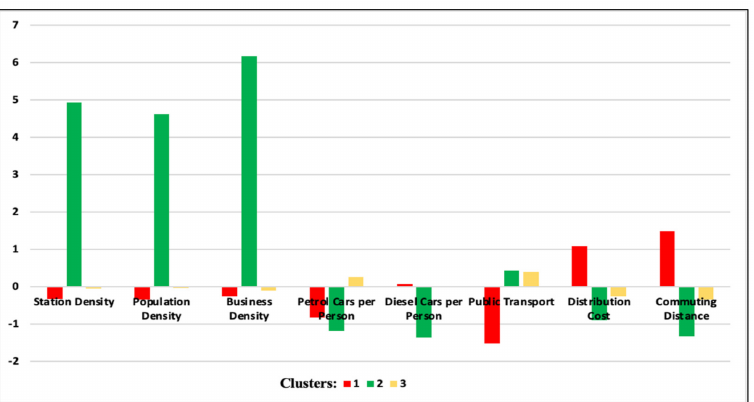
Figure 5. Cluster means of attributes in each cluster. Note: this figure used the information presented in Table 3 to show the cluster means of attributes in each of the three clusters more visibly.